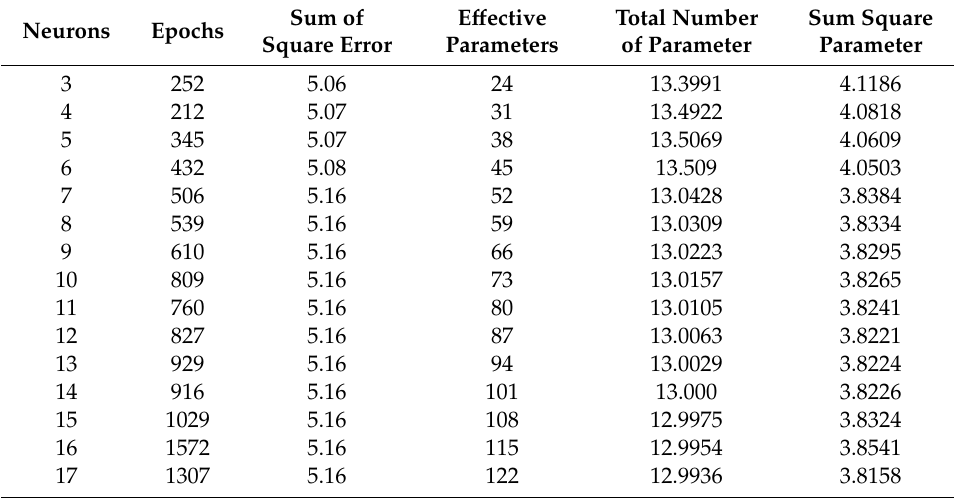
Table 10. Training result for hidden layer 1.